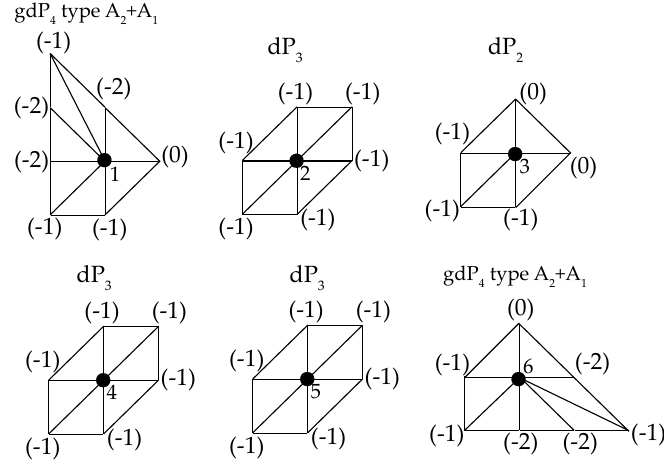
Figure 3 . The toric fan of each compact surface S i . The subscript i is labelled at the center of each toric fan, and the self-intersection number of each toric curve is written in the brackets. gdP n refers to the generalized del Pezzo